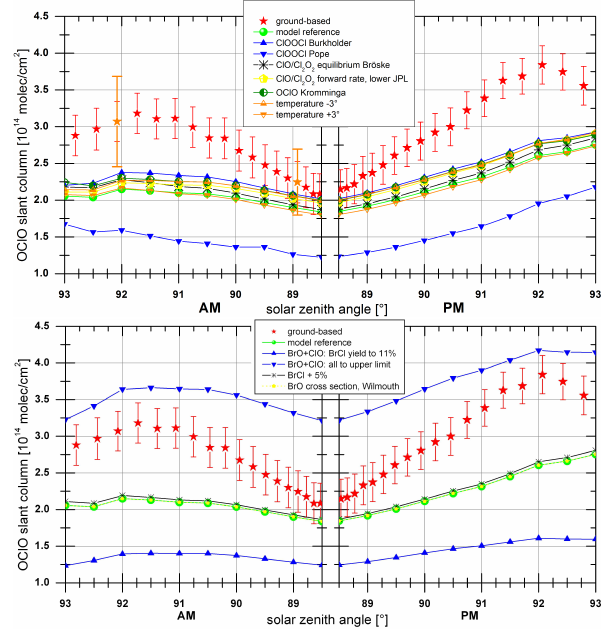
Fig. 8. Sensitivity Studies: measurements and model calculations of OClO slant columns at Ny- ˚Alesund for 24 February. The error bars represent the 2 σ error of the measurements. Exemplarily, two error bars have been added to the top panel indicating the overall measurement uncertainty of 20%. Sensitivity studies have been un- dertaken by changing the mechanism. The different scenarios are indicated in the box embedded in the figure and are explained in Sect.